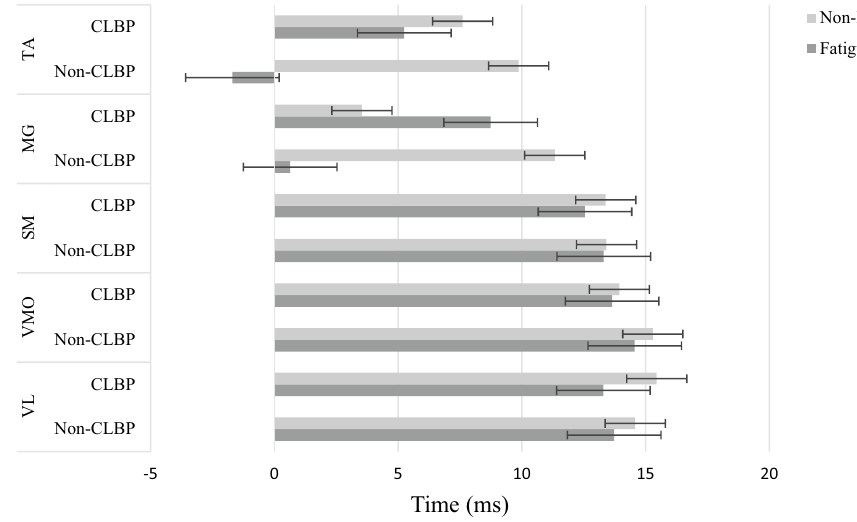
Figure 7. EMD for each muscle by groups (CLBP and Non-CLBP) in non-fatigued and fatigued. VL, Vastus Lateralis; VMO, Vastus Medialis Oblique; SM, Semitendinosus; MG, Med gastrocnemius; TA, Tibialis